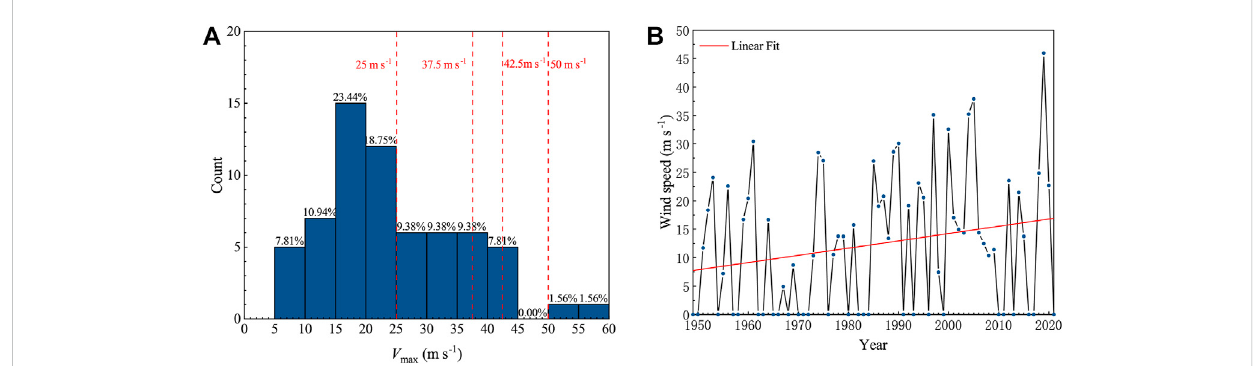
FIGURE 7 (A) Frequencydistributionofmaximumwindspeedathubheight( V farm under tropical cyclone conditions during 1949 – 2021. Orange dashed lines in (A) represent threshold cutoffs of 25, 37.5, 42.5, and 50 m s − 1 ; red line in (B) represents the linear fi t of the annual maximum wind